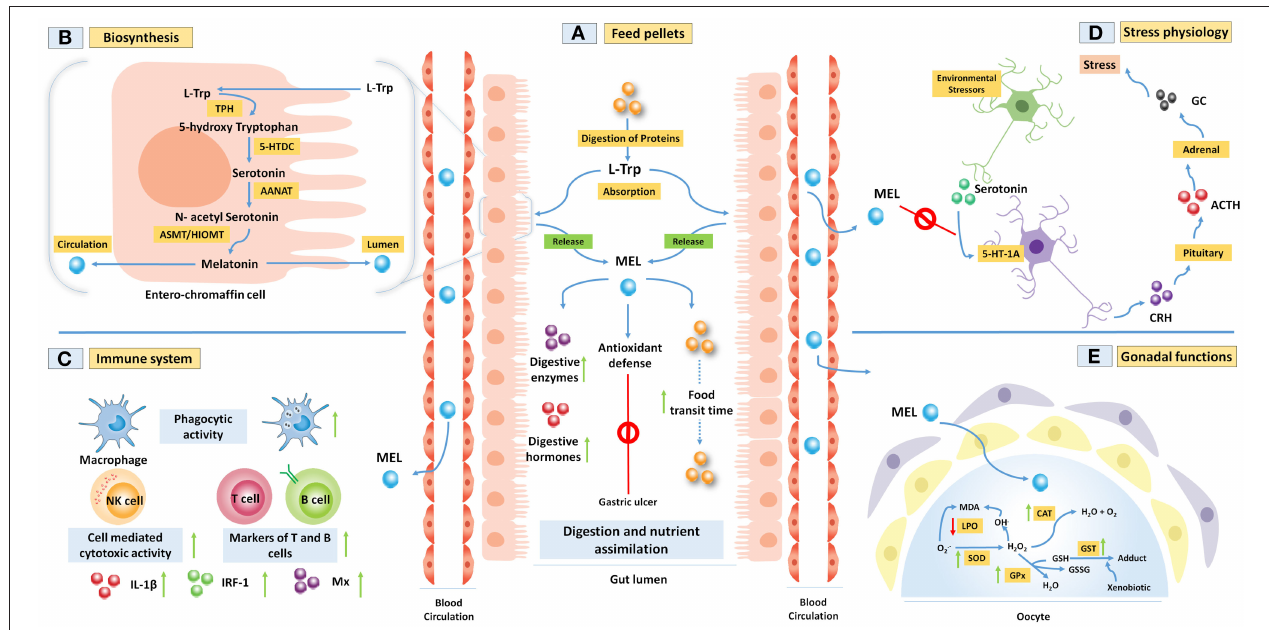
FIGURE 1 | (A,B) Melatonin (MEL) is synthesized from amino acid L-tryptophan (L-Trp) within the fish gut epithelial cells. This process includes four steps of enzymatic reactions. Gut MEL increases the activity of digestive enzymes and helps in the assimilation of food materials. It also abrogates gastric ulcers by activating the antioxidant defense system. (C) MEL improves fish immune functions by increasing the phagocytic activity of the macrophages, cell-mediated cytotoxicity, markers of T and B cells, and several immune regulators like interleukin-1 beta (IL-1 β ), interferon-regulatory factor 1 (IRF-1), and Mx proteins. (D) Further, MEL downregulates the environmental stressor-induced release of glucocorticoid (GC) from the adrenal through the activation of 5-HT-1A receptor in fish. (E) MEL acts as a potent antioxidant through increasing the activity of antioxidative enzymes in carp ovary to regulate the